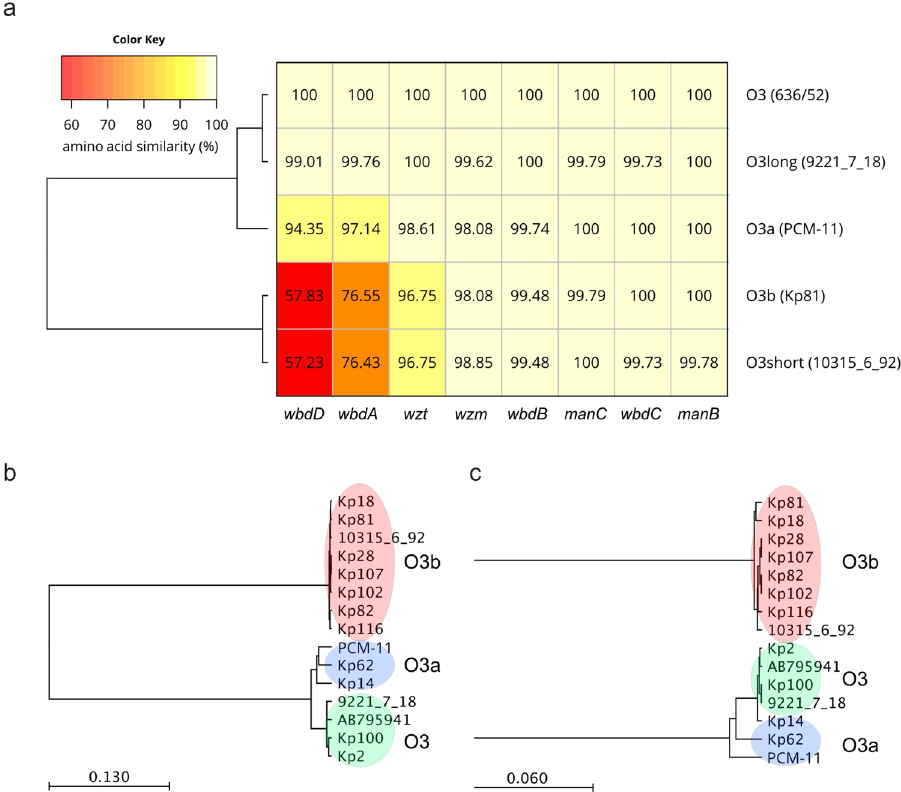
Figure 4. Schematic alignment and taxonomy of the rfb operons encoding O3 antigens. The percent homologies of individual gene products compared to those of archetype O3 strain 636/52 (AB795941.1) are shown for representative strains expressing O3, O3a or O3b antigens ( a ). In addition, the two genotypes “O3 short” and “O3 long” of O3 rfb operons recently described by Follador et al . 5 are shown. Phylogenetic trees for WbdD ( b ) and WbdA ( c ) were